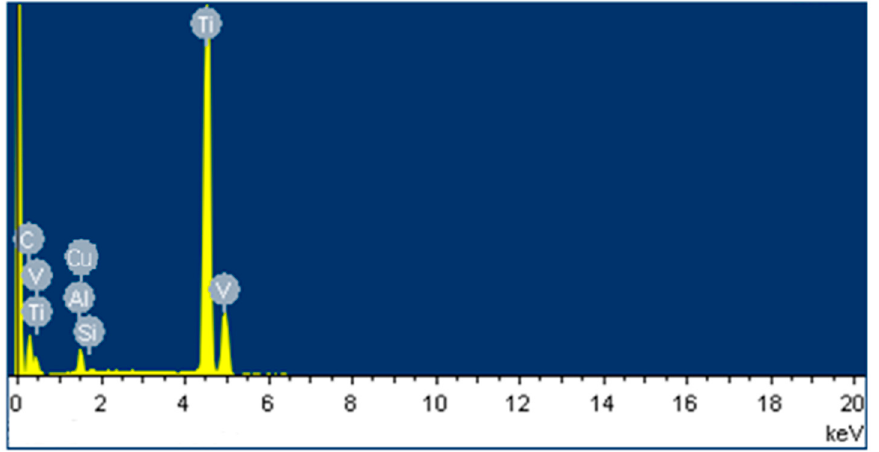
Figure 14. EDS analysis of machined Ti-6Al-4V alloy when Cu-SiC electrode was used at current = 1.5 A, pulse on-time = 15 µs, and pulse off-time = 15 µs [68]. (With kind permission from